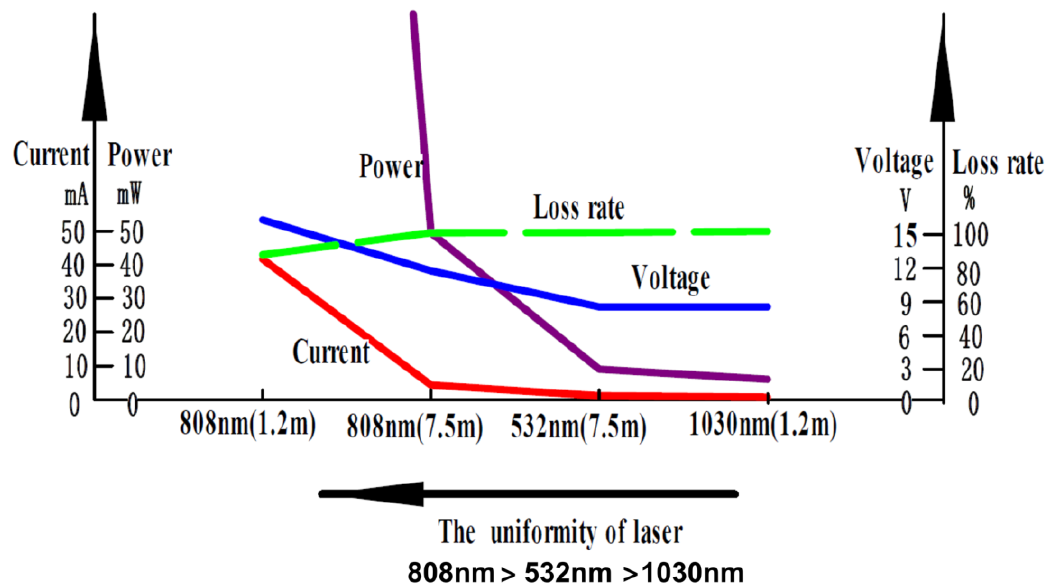
Figure 12. Comparison of re sults under different wavelengths of laser irradiation.